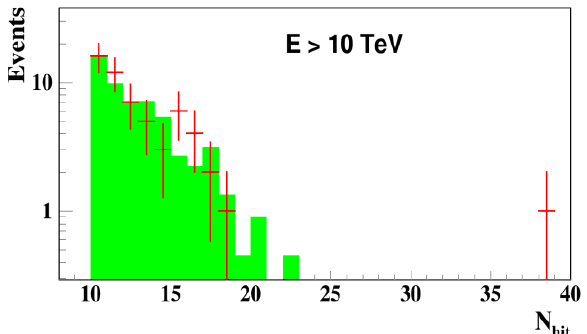
Fig. 2. Multiplicity distribution of hit OMs for data (points) and atmospheric muons (histogram), for events with reconstructed energies E sh > 10 TeV.